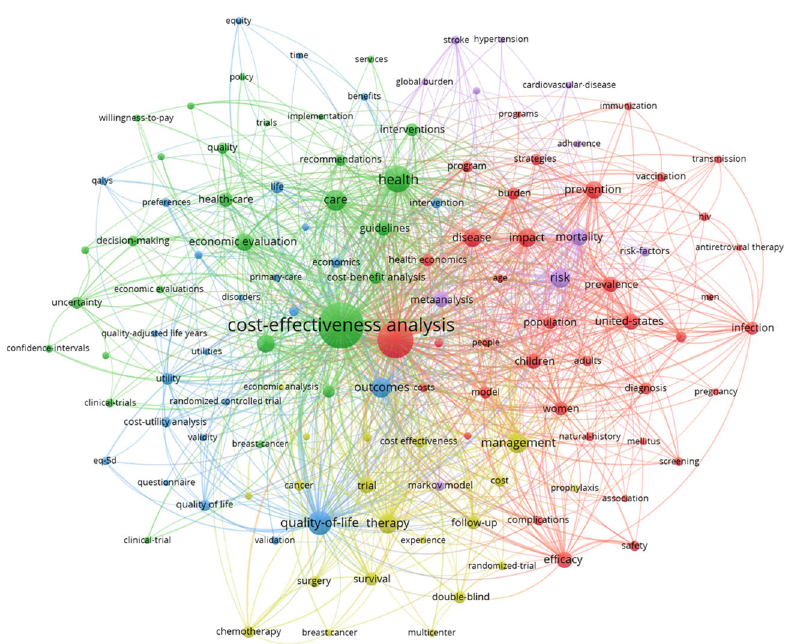
Fig. 11 Keyword network. Source: